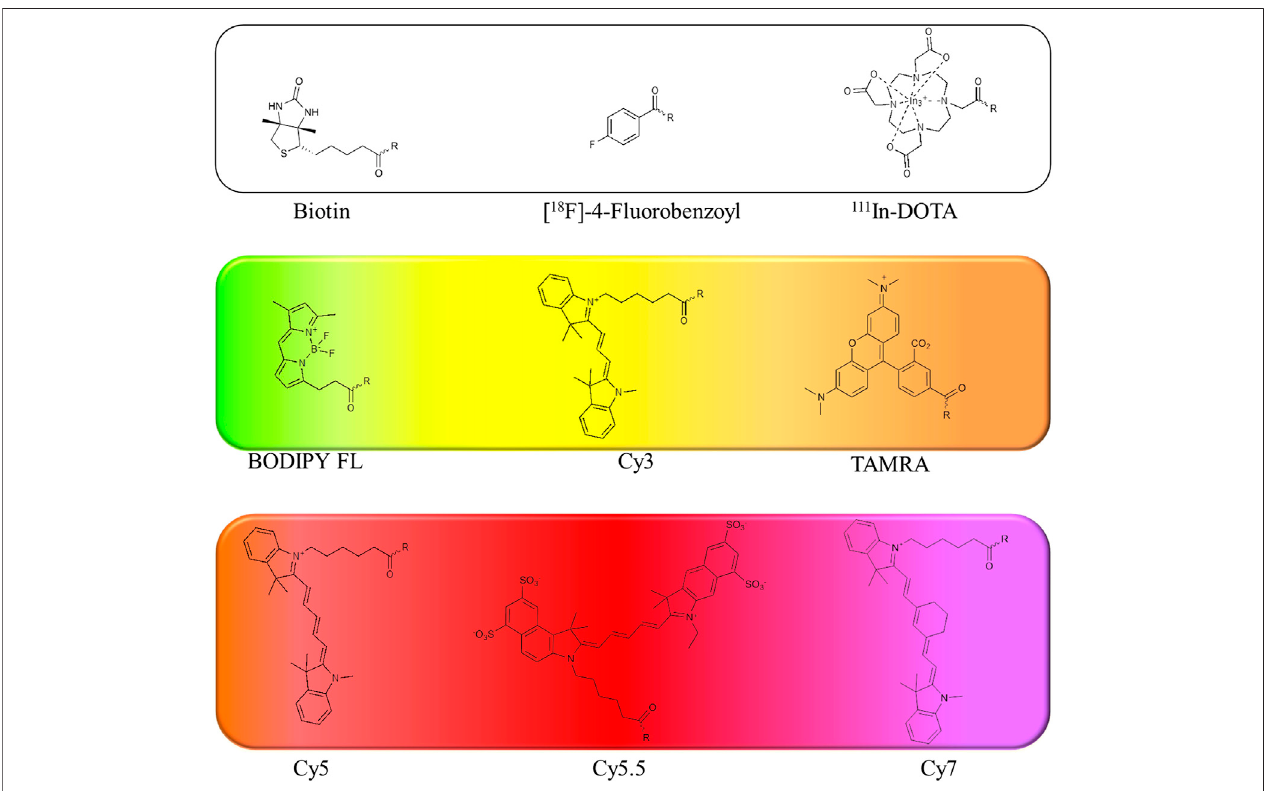
FIGURE 7 | Examples of af fi nity, fl uorescent and metal tags applied in the imaging of serine proteases.